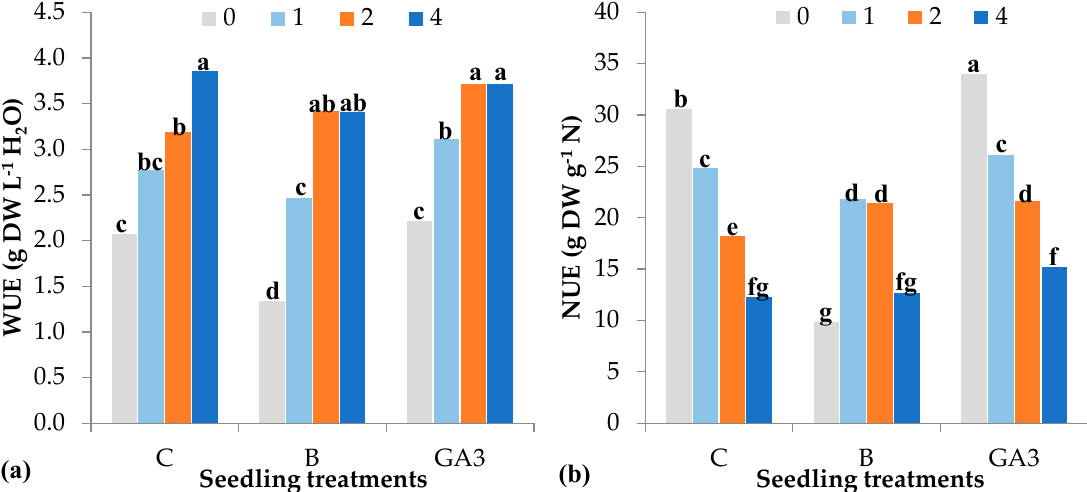
Figure 6. E ff ect of the seedling treatments (C, untreated control, B, bacterial biostimulant, GA3, gibberellic acid spray 10 − 5 M) and the nursery fertigation rates (0, 1, 2 and 4 g L − 1 of NPK 20-20-20) on ( a ) the water use e ffi ciency (WUE) and ( b ) the nitrogen use e ffi ciency (NUE) of Solanum lycopersicum ‘Marmande’ seedlings (bars with di ff erent letters are significantly di ff erent at p < 0.05 according to the LSD test).